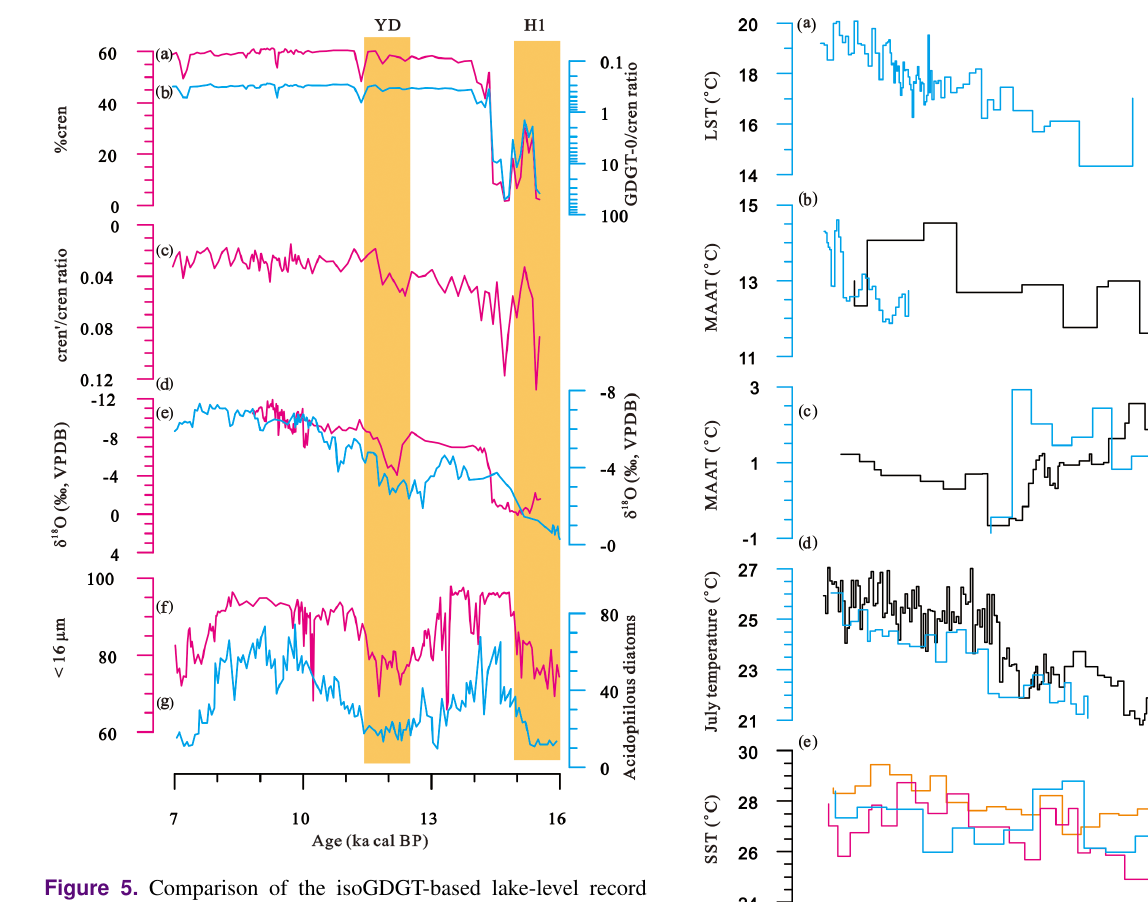
Figure 5. Comparison of the isoGDGT-based lake-level record from Lake Chenghai (a–c) with the δ 18 O record of carbonate finer in grain size than 63µm from Lake Chenghai ( d , Sun et al., 2019), the stalagmite δ 18 O records from Mawmluh Cave in northeast In- dian ( e , Dutt et al., 2015); grain-size and diatom record from Lake Tengchongqinghai ( f and g , Zhang et al., 2017b; Li et al., 2018). The shading is utilised to represent “cold” events in the North Atlantic.